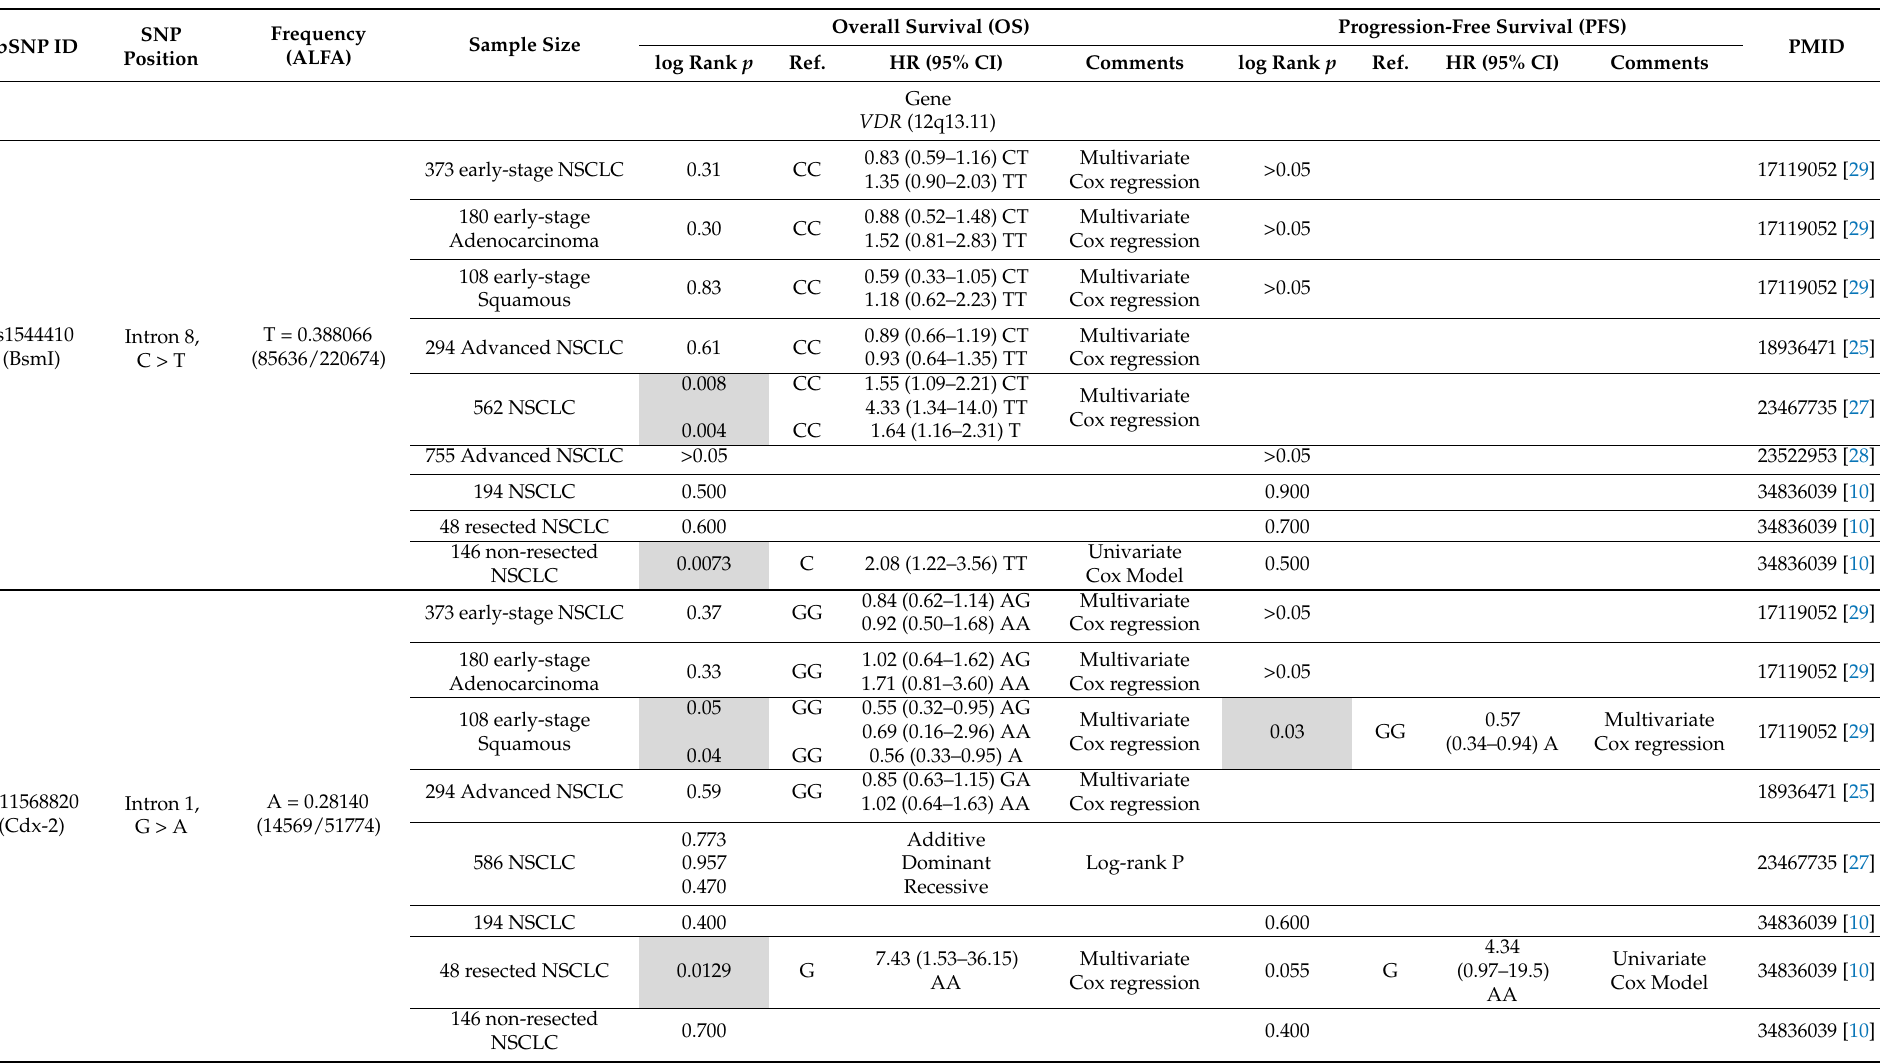
Table 3. SNPs associated with Overall Survival and Progression-free Survival in NSCLC